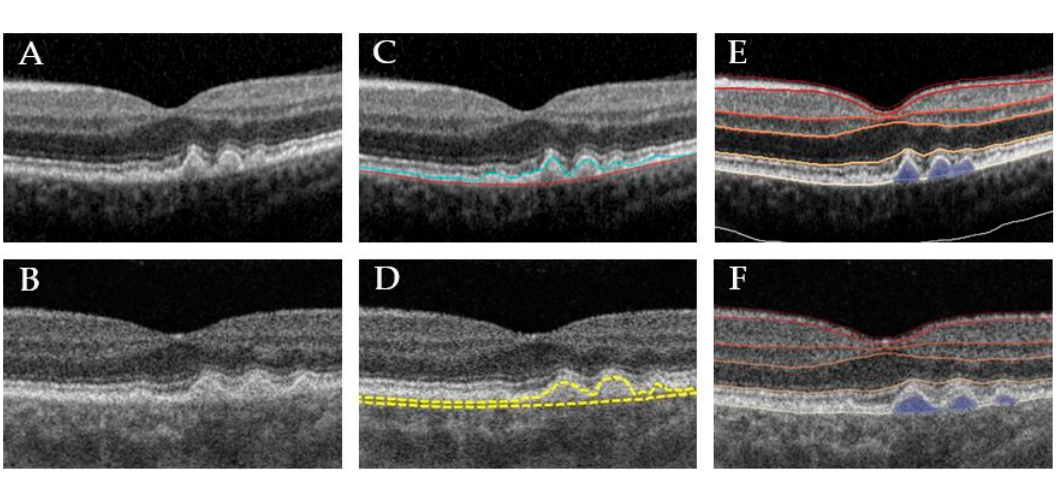
Figure 1. Representative example of different drusen segmentations. Left: unsegmented B-scan of Heidelberg Spectralis Spectral Domain Optical Coherence Tomography (SD-OCT) ( A ) and Zeiss Swept-Source PlexElite Optical Coherence Tomography (SS-OCT) ( B ). Middle: machine inbuilt segmentation of Heidelberg ( C ) and Zeiss SS-OCT ARI network test algorithm based on Cirrus segmentation algorithm ( D ). Right: segmentation of Heidelberg Spectralis SD-OCT ( E ) and Zeiss SS-OCT B-scan ( F ) B-scan using customized, third-party Discovery software, respectively.